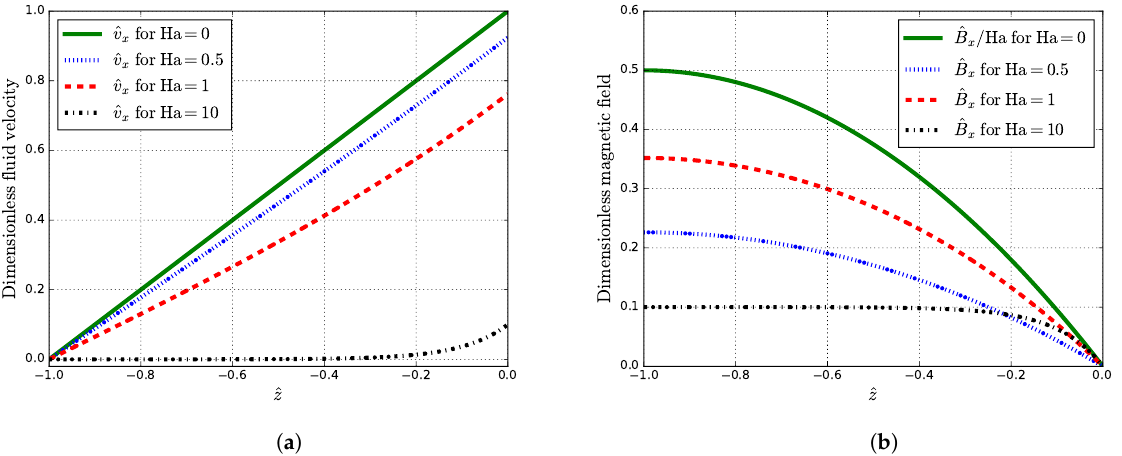
Figure 2. Dimensionless quantities: ( a ) velocity ˆ v x and ( b ) induced MF ˆ B x , given by (19) and (20), as functions of ˆ z . For small Ha, ˆ v x = 1 + ˆ z + O ( Ha 2 ) and ˆ B x = − Haˆ z ( ˆ z /2 + 1 ) + O ( Ha 3 ) . As shown in Figure 2a, the value of ˆ v x is dampened as Ha grows. As the Ha number increases, ˆ B x decays (Figure 2b). Notice that at Ha = 1, the induced MF at the liquid–solid interface is slightly higher than at Ha = 0.5. Velocity ˆ v x ( ˆ z ) and induced MF ˆ B x ( ˆ z ) reach their maxima at ˆ z = 0 and ˆ z = − 1, respectively, where their values are